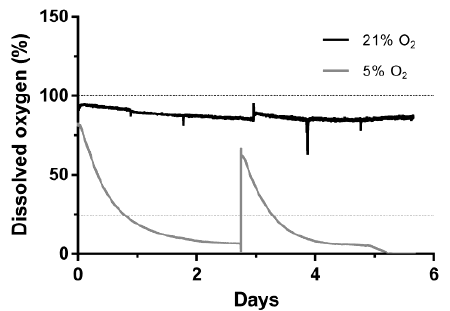
Figure 2. Dissolved oxygen during cultivation mesenchymal stem cells in continuously stirred tank reactor at 21% or 5% O 2 ambient oxygen. Dashed lines indicate the respective dissolved oxygen concentration at respective equilibrium.